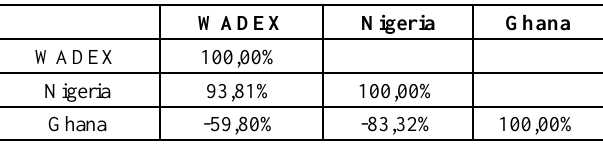
Table 5: Correlation analysis of WADEX and West